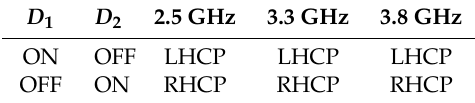
Table 2. Switching of the CP-sense according to the state of the PIN diodes.